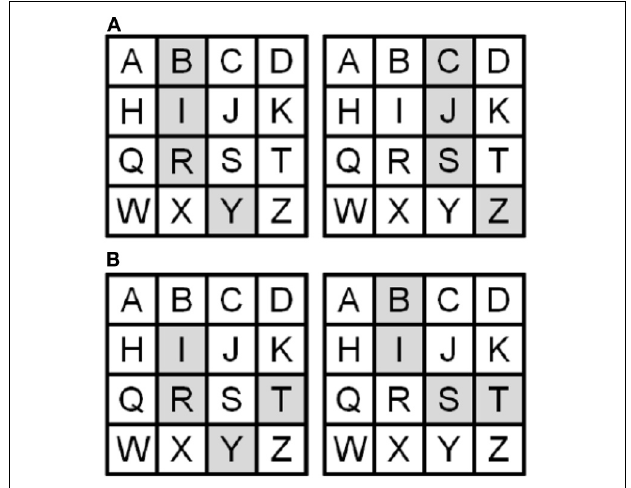
FIGURE 1 | Representative shapes in the lettered matrix with sample pairs of (A) “same” (B-I-R-Y vs. C-J-S-Z) and (B) “different” shapes (I-R-Y-T vs.